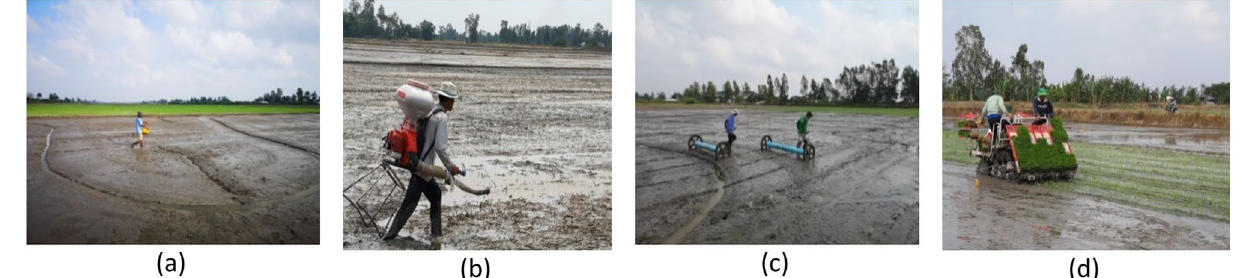
Figure 1. Four crop establishment practices showing ( a ) manual broadcasting (BroadC), ( b ) blower seeding (BlowS), ( c ) drum seeding (DrumS) and ( d ) mechanical transplanting (MecT). The people with their images included in Fig. 1 have consented to publish the paper as online open-access material.